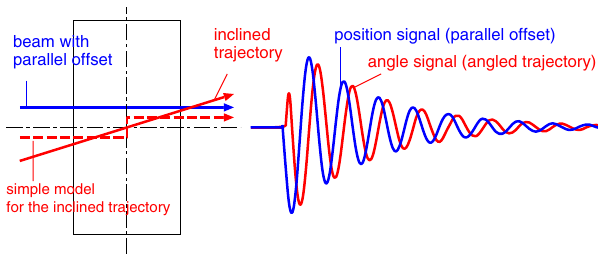
FIG. 2. (Color) Signal of inclined trajectory. The parallel offset of beam orbit and inclined orbit excites the same dipole mode but in a 90-degree different